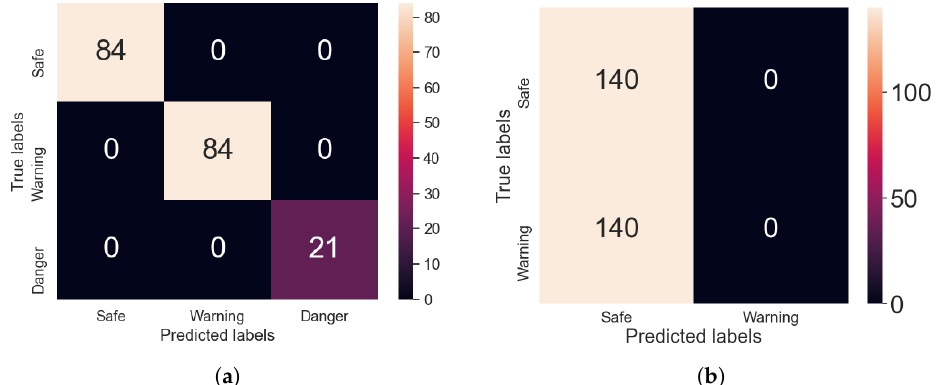
Figure A1. Confusion matrix on the predictions from the Transformer/CNN model, given testing data of samples from ( a ): the steel impactor test and ( b ): the silicone impactor